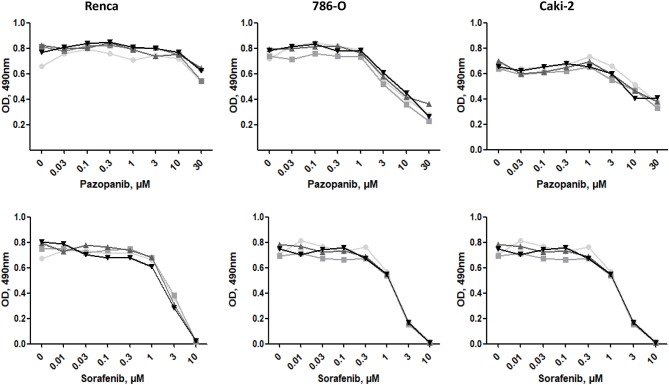
Effect of ECM on drug sensitivity. RCC cells were cultured on plastic , Col 1 , FN1 , or Matrigel  for 24 h. Then, cells were treated with increasing concentrations of Pazopanib or Sorafenib for 24 h. Cell viabilities were assessed with MTS.